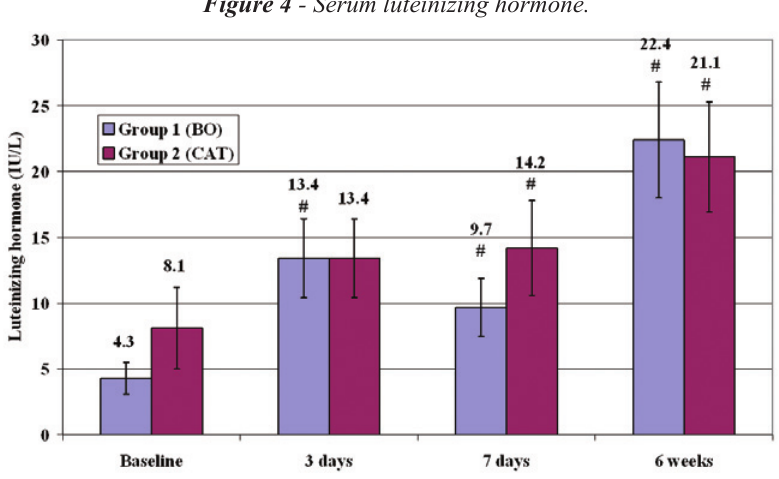
Figure 4 - Serum luteinizing